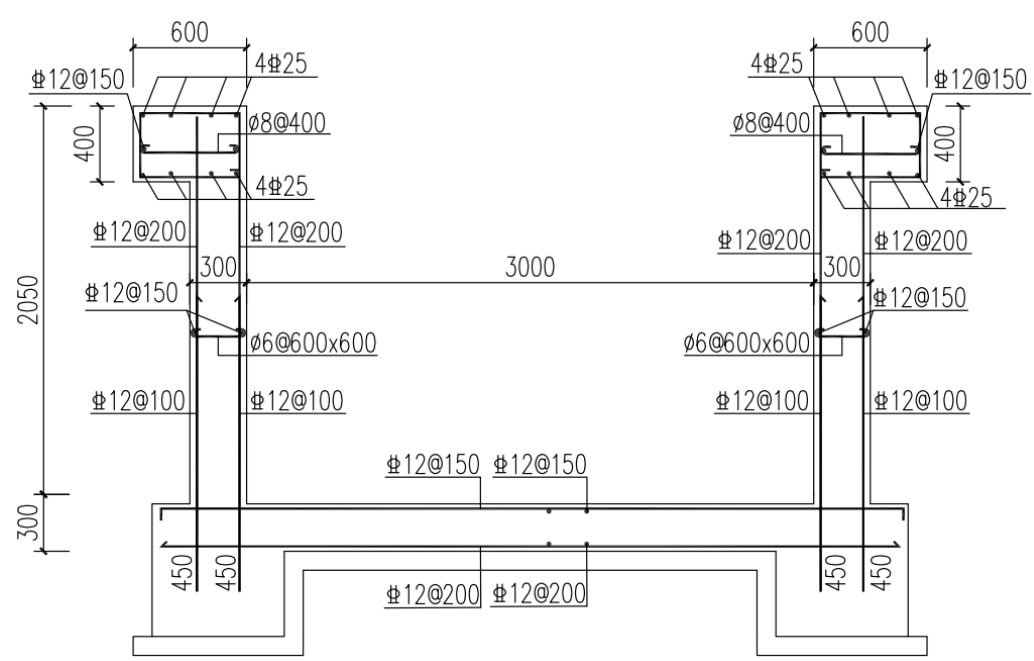
Figure 2. Reinforcement arrangement of the soil tank.